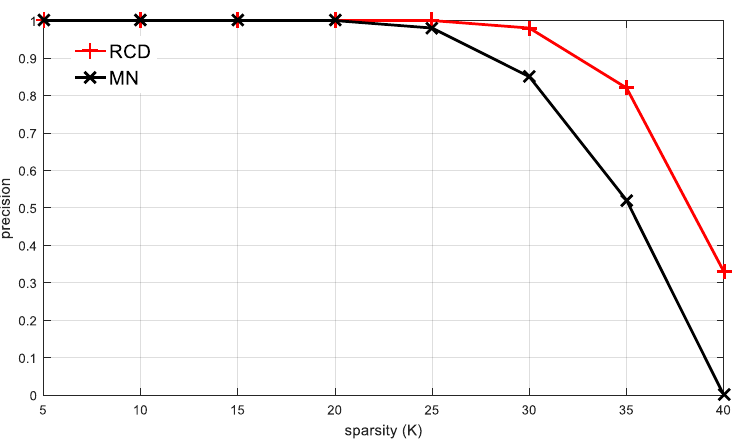
Figure 8. Comparison of randomized coordinate descent (RCD) and modified Newton (MN) (changed K ).